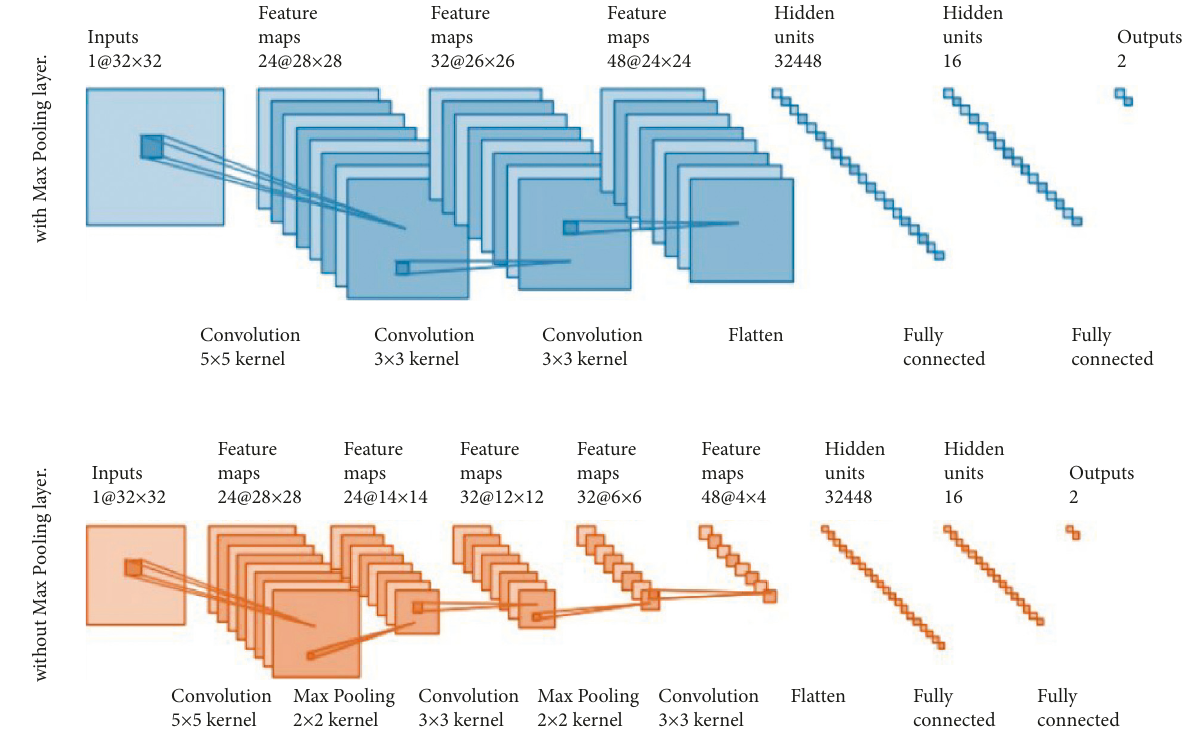
Figure 2: Architecture for 1 implemented input of the CNN with and without Max pooling